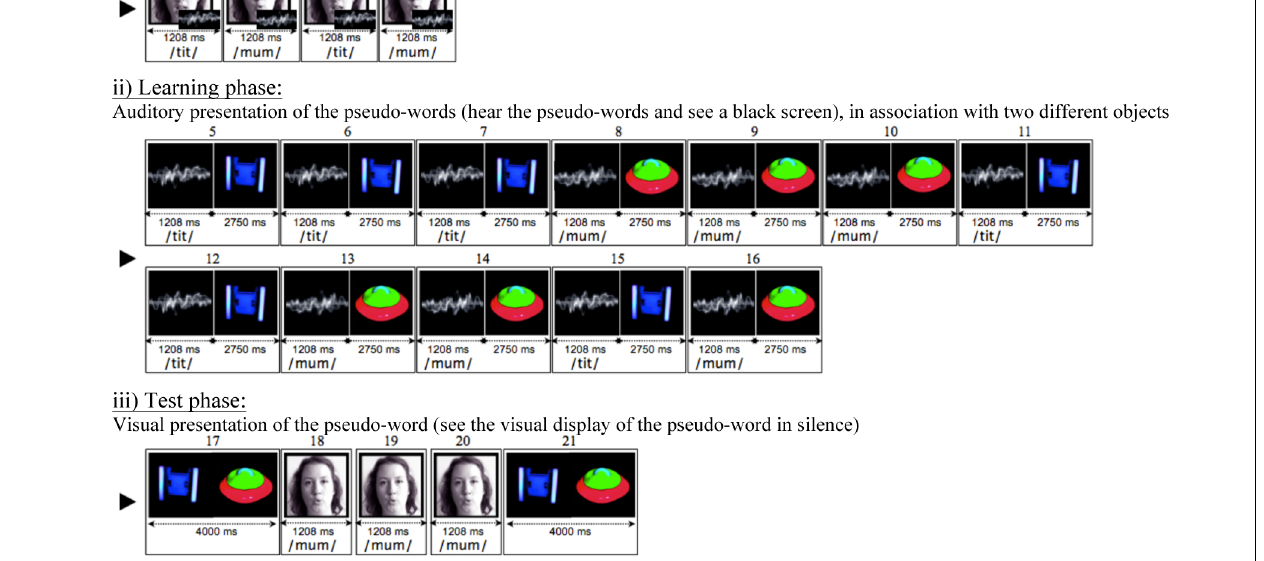
Frontiers in Psychology |